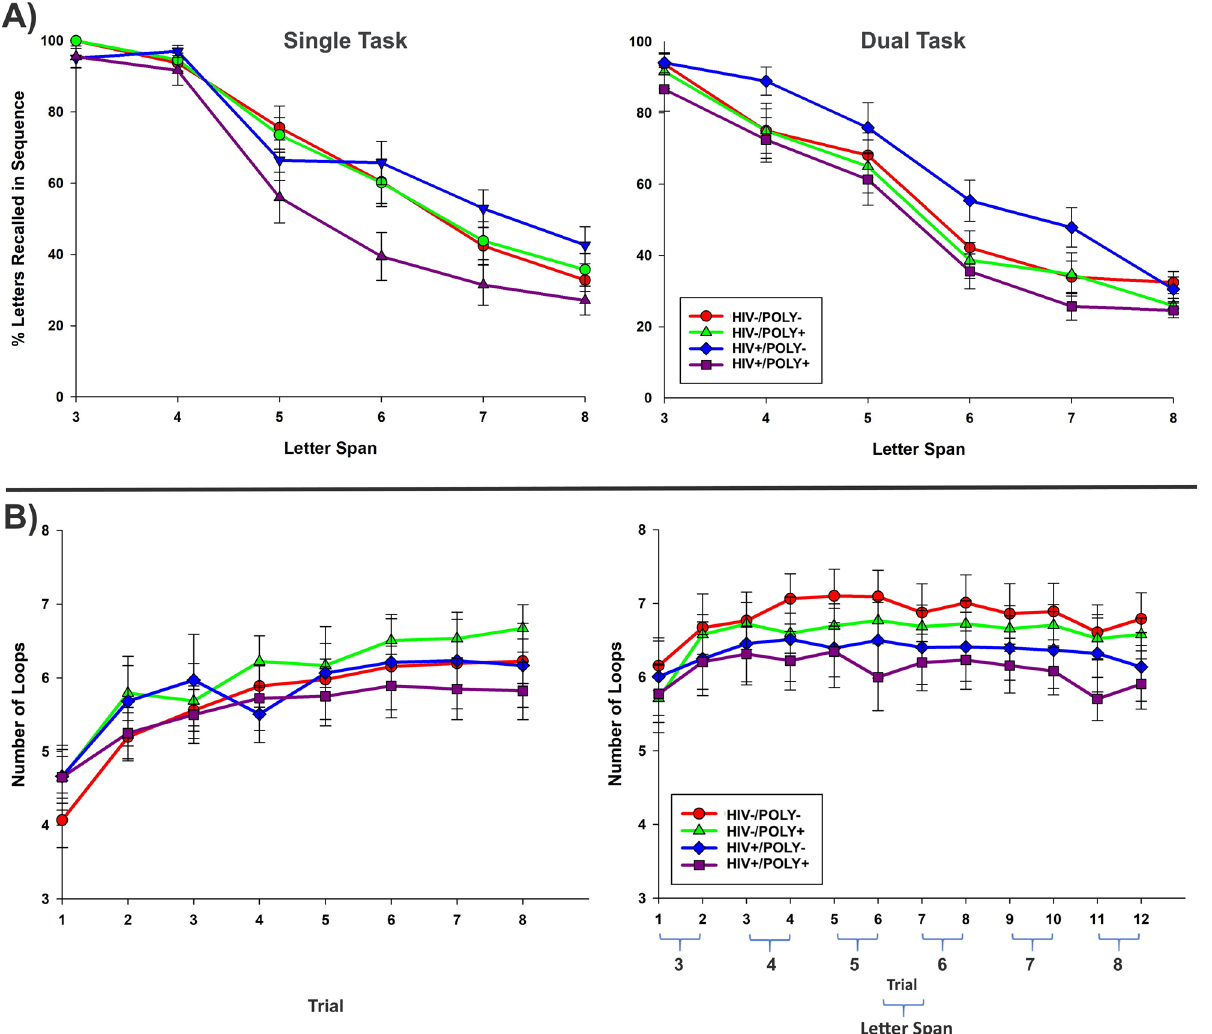
Figure 1. Working memory and loop drawing performance during single and dual task conditions . ( A ) The percent accuracy of letter spans recalled in sequence are reported across trials of increasing letter spans of 3–8 letters. Recall accuracy for letters decreased as the size of letter spans increased, especially in the dual task condition when working memory was performed in conjunction with a motor task. In the single task condition, the HIV + /POLY + group (purple) performed with less accuracy than did the HIV + /POLY- group (blue). ( B ) The number of loops is reported across each 5-s trial. Loop drawing frequency increased across trials, with most gains occurring in the single task condition. In the dual task condition, loop drawing was done in conjunction with a working memory task that increased cognitive load across trials. The HIV-/POLY- group (red) improved motor learning more than any other group did, suggesting that HIV and substance use history impacted performance. However, when HIV and POLY groups were examined collectively, the HIV + groups (blue plus purple) showed impaired motor learning, whereas the POLY + groups (green plus purple) did not. (Trials 9–12 of the dual task were not included in omnibus analysis). Bars denote one standard task were included because we could not load an uneven number of trials into the ANOVA. Results revealed an interaction of trial x group, F (21, 392) = 2.02, p = 0.005 (See Supplement 1for additional results). Post-hoc tests indicated that the HIV-/POLY- showed a greater increase in loop drawing across trials (i.e., motor learning) than did all other groups. The remaining groups did not differ from one another. To investigate how the HIV + groups performed regardless of substance dependence history, we conducted a mixed-design ANOVA with 8(trial) × 2(condition) as within-subjects factors and 2(group: HIV- (collapsed across POLY- and POLY +) and HIV + (collapsed across POLY- and POLY +)) as a between-subjects factor. There was an interaction of trial x group, F (7, 406) = 5.01, p < 0.001, indicating that the HIV + group showed a disproportionately slow rate of motor improvement across trials (See Supplement 1 for additional analyses). We also examined how POLY + groups performed regardless of HIV status. We conducted a mixed-design ANOVA with 8(trial) × 2(condition) as within-subjects factors and 2(group: POLY- (collapsed across HIV- and HIV +) and POLY + (collapsed across HIV- and HIV +) as a between-subjects factor. There was no main effect of group